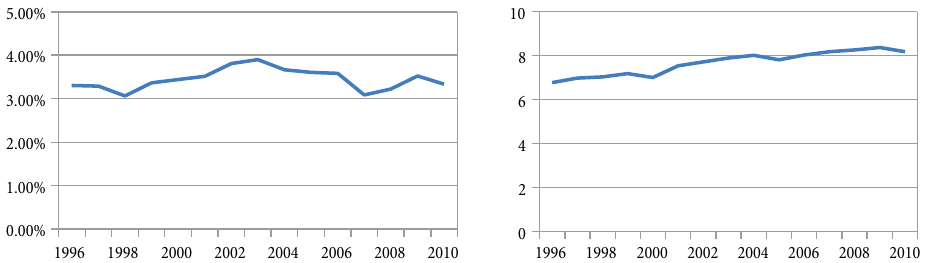
Fig. 1. Ratio of education expenditure to GDP and average schooling years during 1996 and